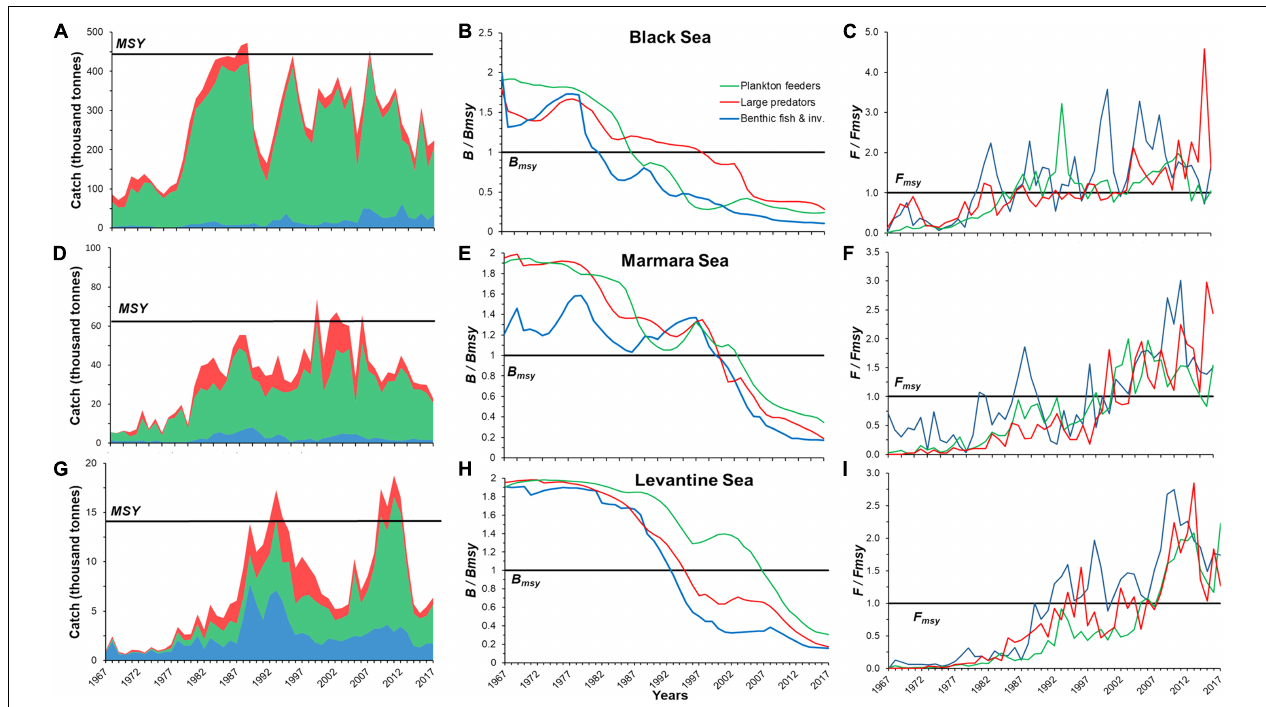
FIGURE 3 | Time-series of stock status by functional group (red: large predators, green: pelagic plankton feeders, blue: benthic species) for the Black Sea, Marmara Sea, and Levantine Sea, from 1967 to 2017. Summed catch (A,D,G) , median biomass relative to the level that can produce the MSY (B/Bmsy; B,E,H ), and median fishing mortality (C,F,I) relative to the MSY level (F/Fmsy) is shown respectively for 17 stocks in the Black Sea (A–C) ; 17 stocks in the Marmara Sea (D–F) , and 21 stocks in the Levantine Sea (G–I) . The black lines indicate the summed MSY, sustainable stock biomass at Bmsy level, and fishing mortality at Fmsy level, respectively, going from left to